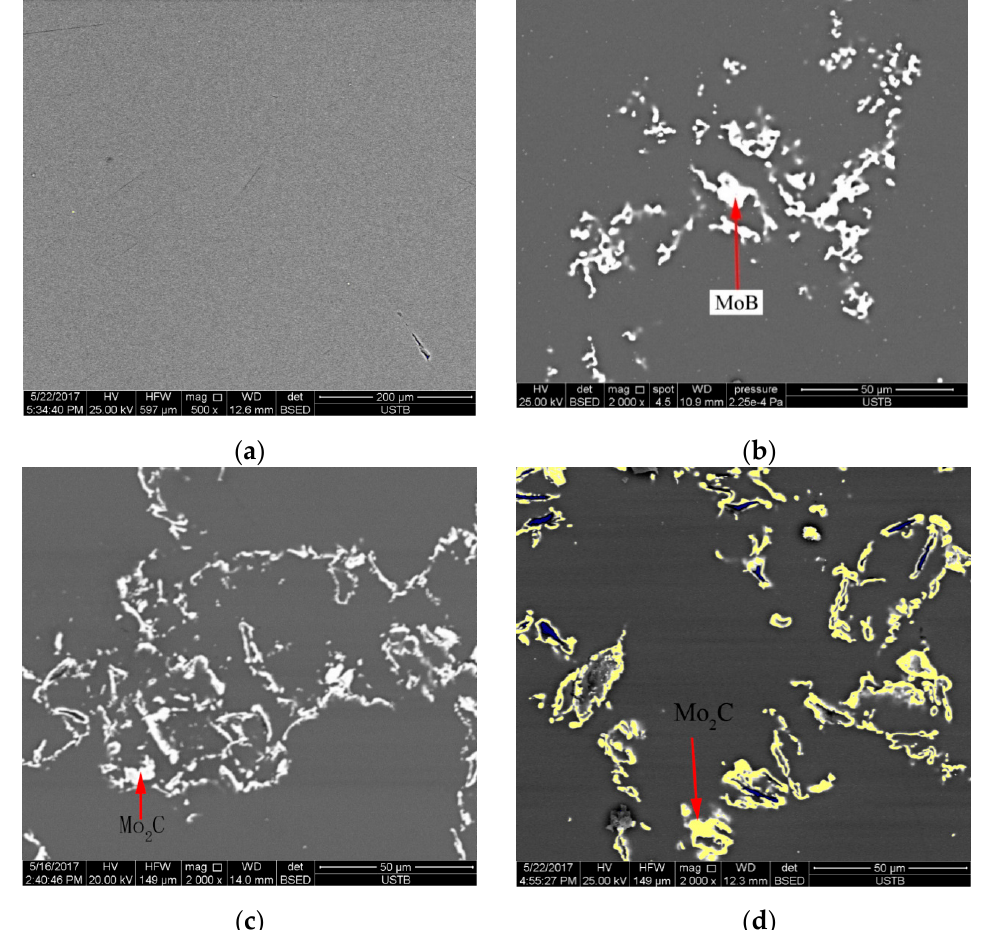
Figure 1. Micrographs of disk samples with different MoO 3 content levels: ( a ) MoO 3 % = 0%; ( b ) MoO 3 % = 2%; ( c ) MoO 3 % = 4%; ( d ) MoO 3 % = 6%.